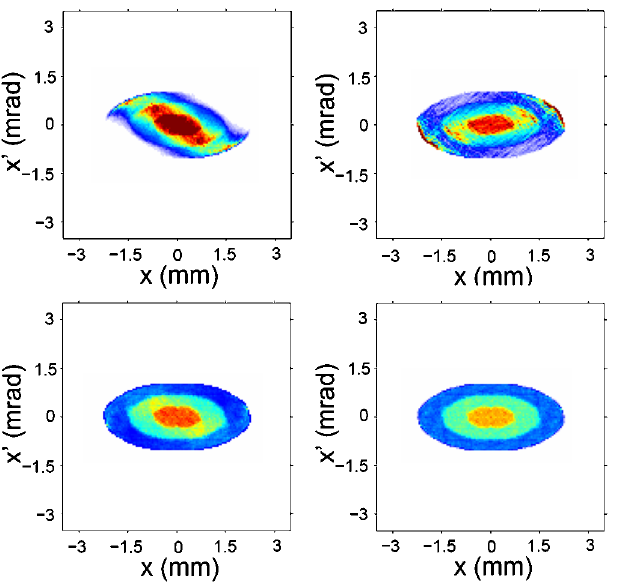
FIG. 2. (Color) Phase space recovered from ART at various iteration cycles: (a) n ¼ 1 ; (b) n ¼ 2 ; (c) n ¼ 4 ; (d) n ¼ 10 . The colors blue, green, yellow, and red indicate increasing intensity.